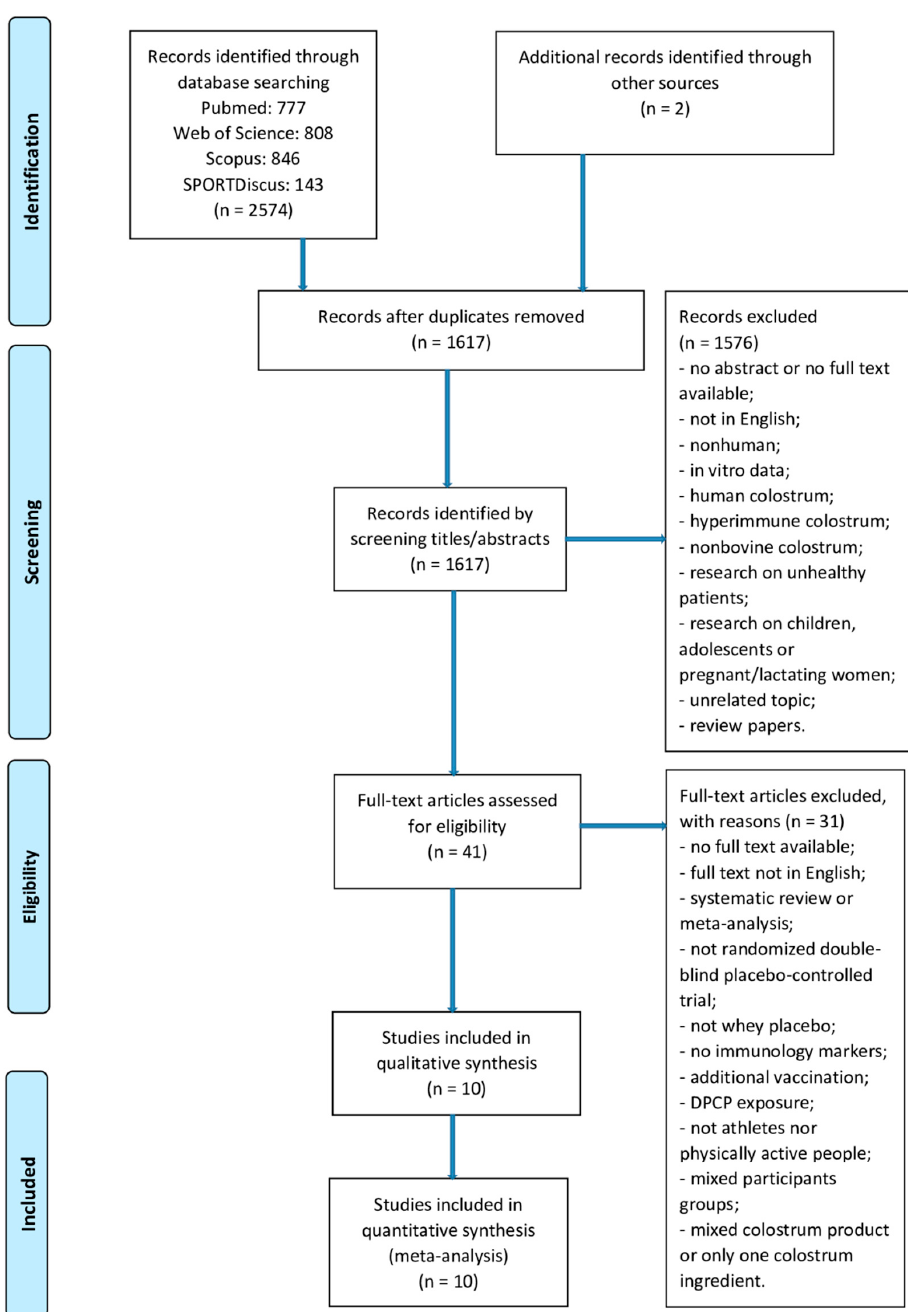
Figure 3. Study selection